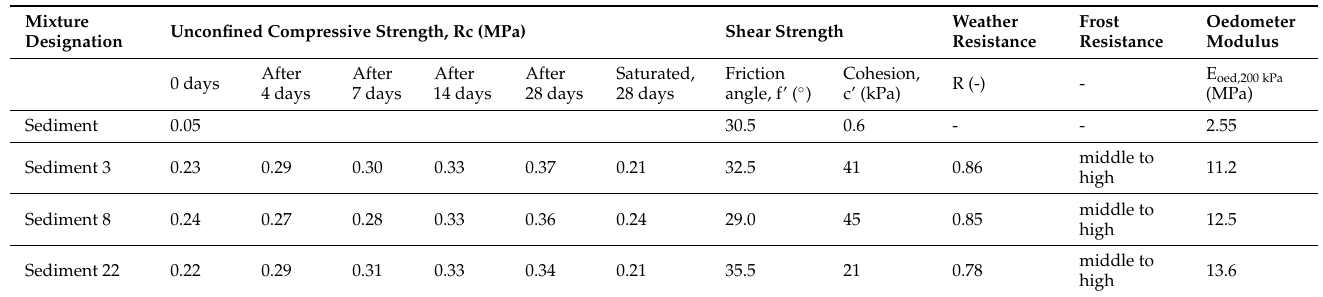
Figure 8. Unconfined compressive strength of the various mixtures; sediments only and sediments containing 3, 8, and 22% of lime additives (full markers representing the fully saturated samples, except the green one). Table 7. Results of the laboratory-based geotechnical tests for sediment only and sediments containing 3, 8, and 22% of lime